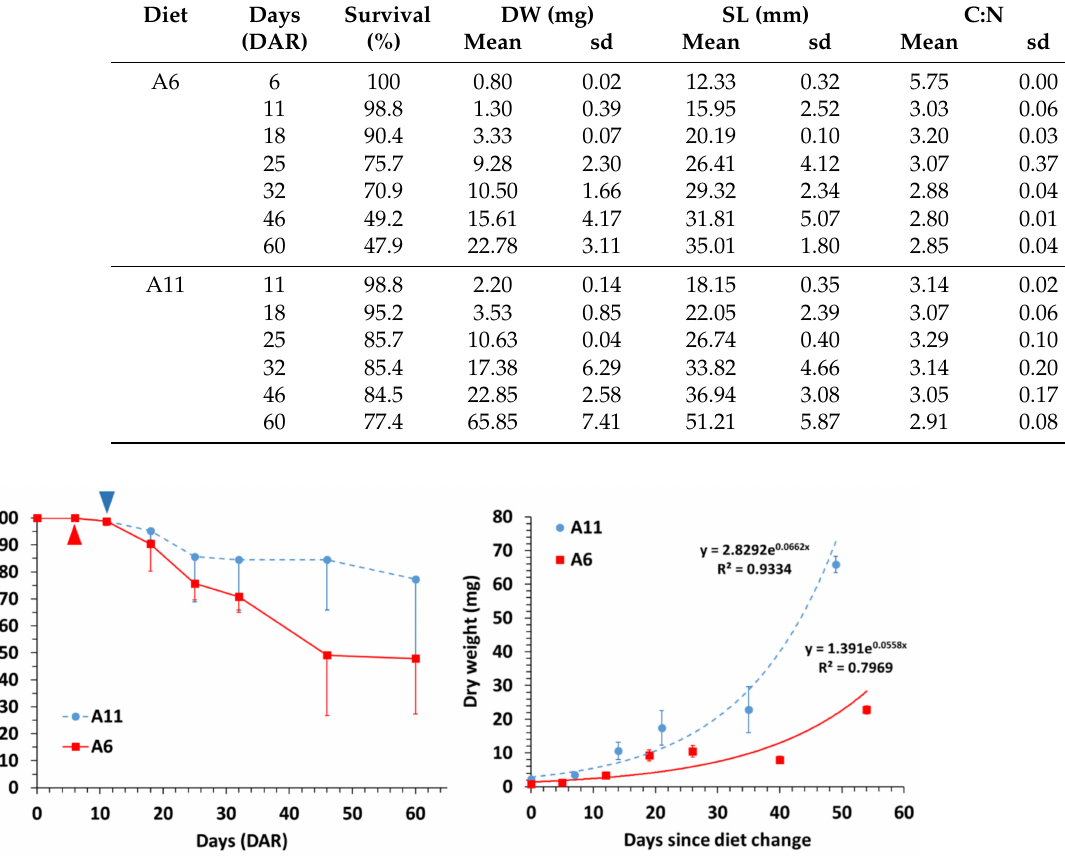
Figure 1. Survival (%) and dry weight (mg) in Hippocampus reidi juveniles fed on dietary schedules A6 and A11. Data are provided as means (two batches per diet) and standard deviations (vertical bars). Triangles: dietary shift (from copepods to Artemia nauplii) in A6 and A11. Growth rates (G R ; mg day − 1 ) in seahorse juveniles were estimated from diet shifting (11 DAR in diet A1; 6 DAR in diet A6) to the end of the experimental period (60 DAR) (Figure 1). Final dry weights and final standard lengths for diet A11 (65.85 ± 7.41 mg; 51.21 ± 5.87%, respectively) were significantly higher than in diet A6 (22.78 ± 3.11 mg; 35.01 ± 1.80%, respectively) (Tukey HSD test; p < 0.0001 and p < 0.001, respectively) (Table 1; Figure 1). C:N ratios declined significantly from 6 DAR to 11 DAR (ANOVA; F (6,14) = 254.7, p < 0.001) and subsequently decreased slightly but not significantly until 60 DAR (2.85 ±